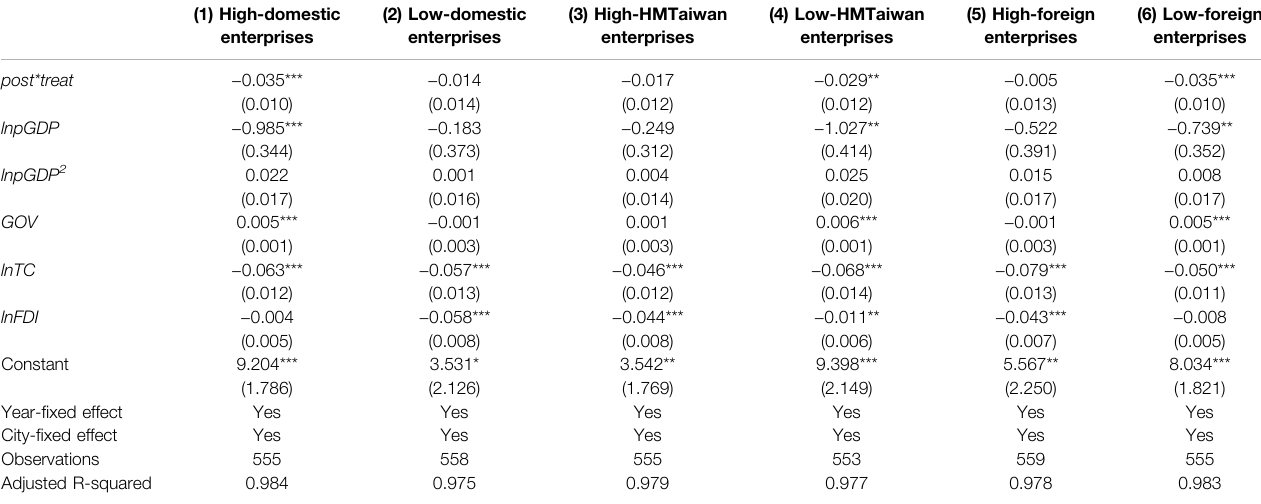
TABLE 6 | Heterogeneity effects of different